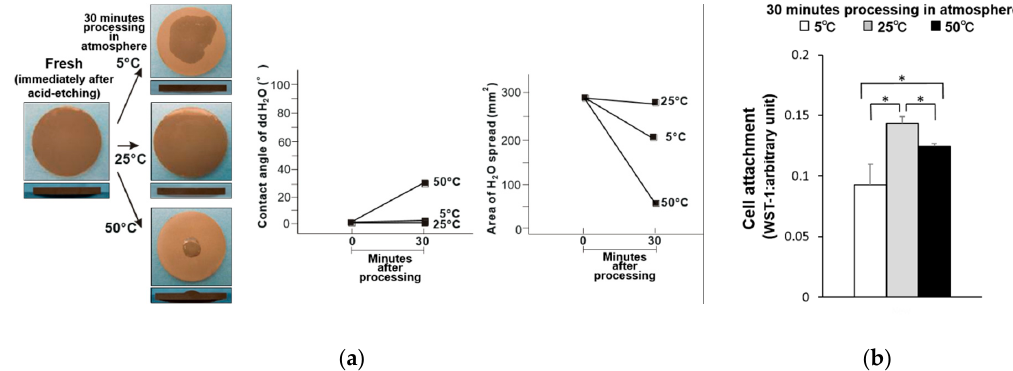
Figure 3. ( a ) Hydrophobicity/hydrophilicity of the fresh–dry titanium disk surfaces illustrated as a photograph of 10 µL ddH 2 O placed on the sample surface before and after temperature deviation (left) with the corresponding contact angle (middle) and spread area (right). ( b ) Initial attachment of osteoblasts to the fresh–dry titanium disk surfaces. * p < 0.05, statistically significant difference.